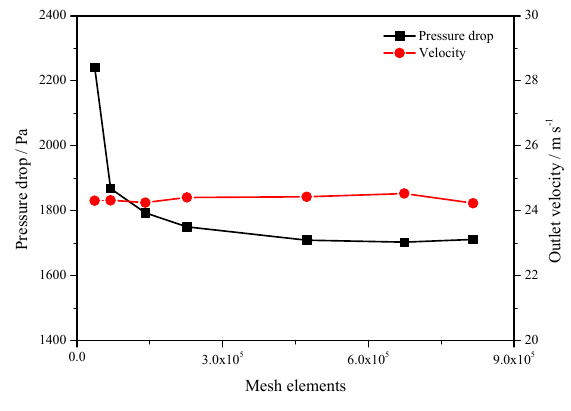
Figure 4. Mesh independence test.